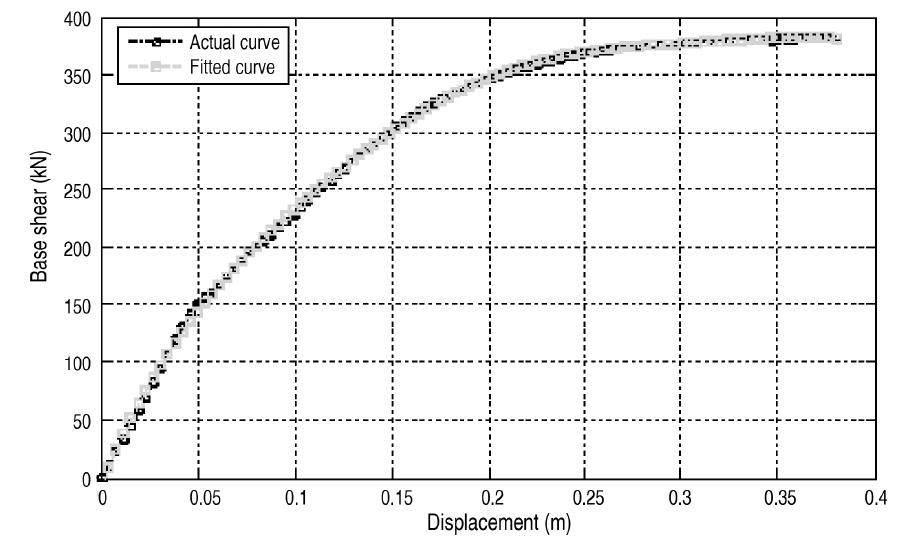
Fig. 9. Actual curve vs. fitted curve by applying the developed